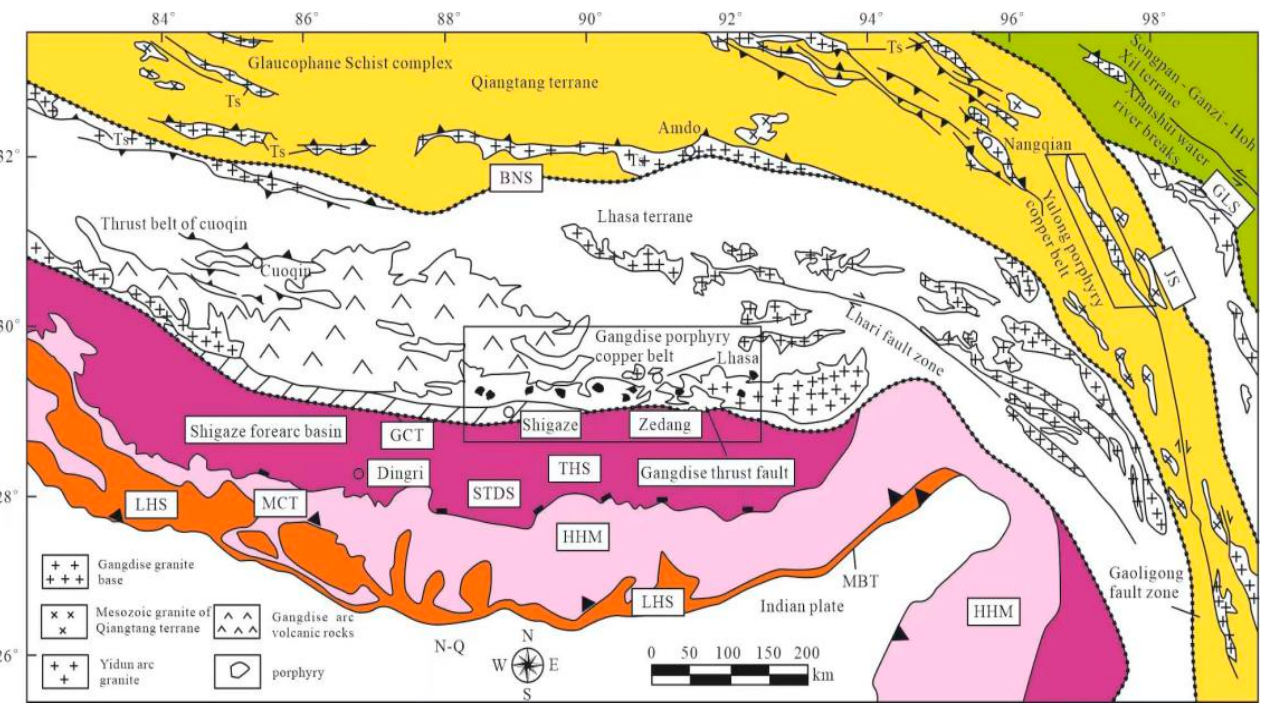
Figure 1. A sketch of the geological background of the East Tethys–Himalayan tectonic belt and the location of the Gondwanan orogenic belt [28,29]. (Ts, tertiary sedimentary rocks; THS, Tethys–Himalayan sedimentary sequence; HHM, high Himalayan metamorphic system; LHS, low Himalayan metasedimentary sequence; IYS, Indus–Yarlung Tsangpo suture zone; BNS, Bengong Lake—Nujiang suture zone; JS, Jinsha River suture zone; AKMS, Animachin–Kunlun–Muzetag suture zone; GLS, Ganzi–Litang suture zone; STDS, Southern Tibetan dissociation system; MCT, main central retrograde fault; MBT, main boundary retrograde fault; GCT, Gondes central retrograde).